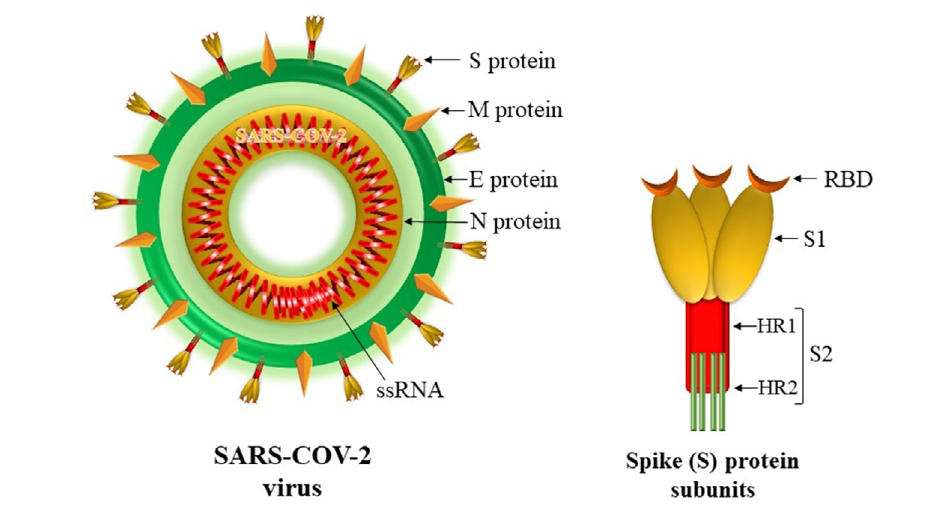
Figure 1. Schematic representation of the SARS-CoV-2 structure and its S protein subunits Immune response against